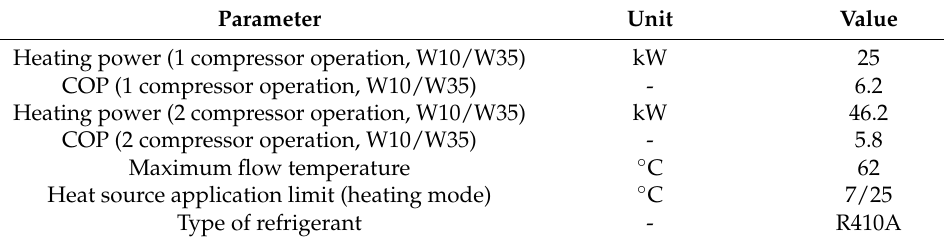
Table 4. Technical data heat pump WI 45TU, manufactured by the Dimplex company.